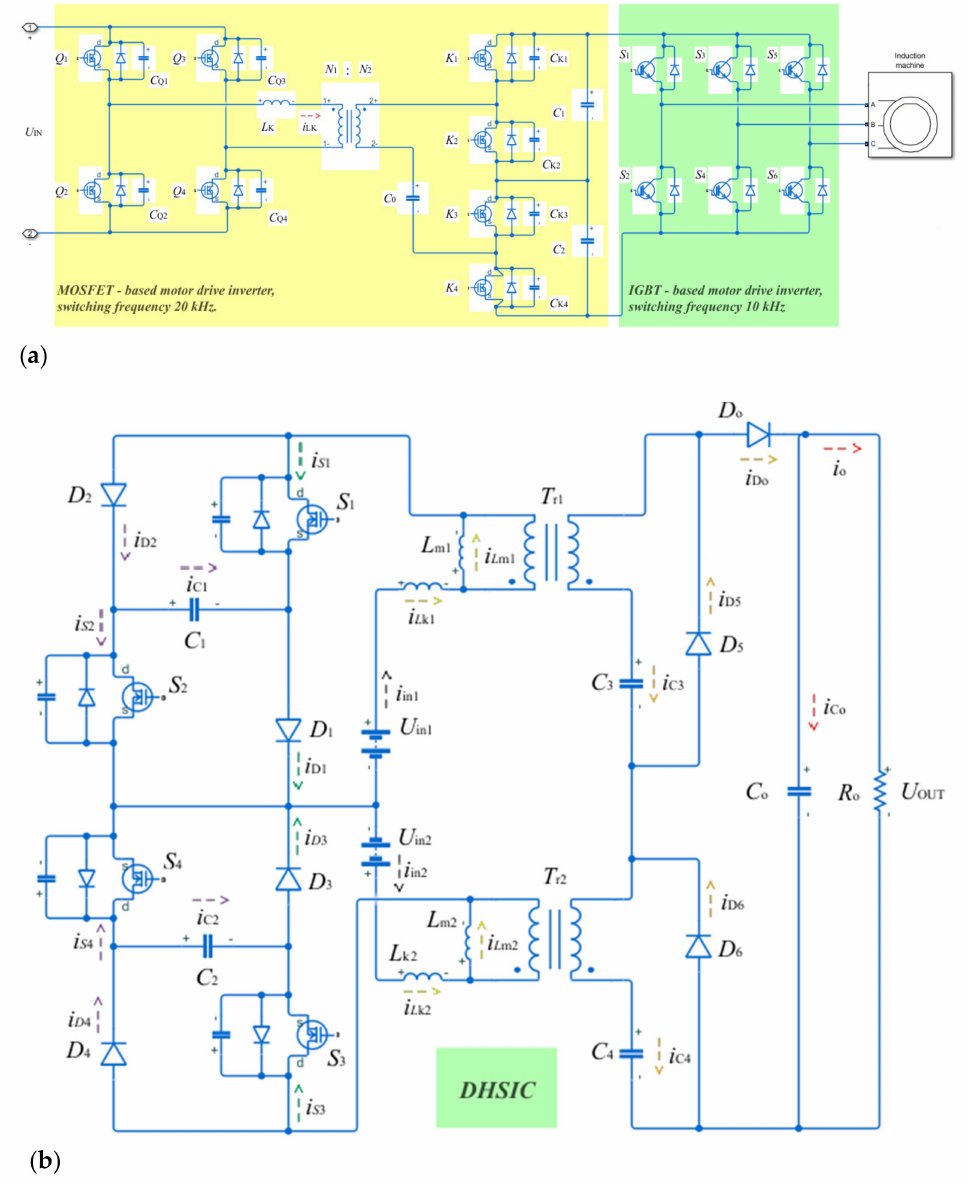
Figure 5. New topologies of Isolated DC/DC Converter. ( a ) Hybrid ZVS (Zero Voltage Switching) Bidirectional DC-DC Converter; ( b ) Dual-Input High Step-Up Isolated Converter